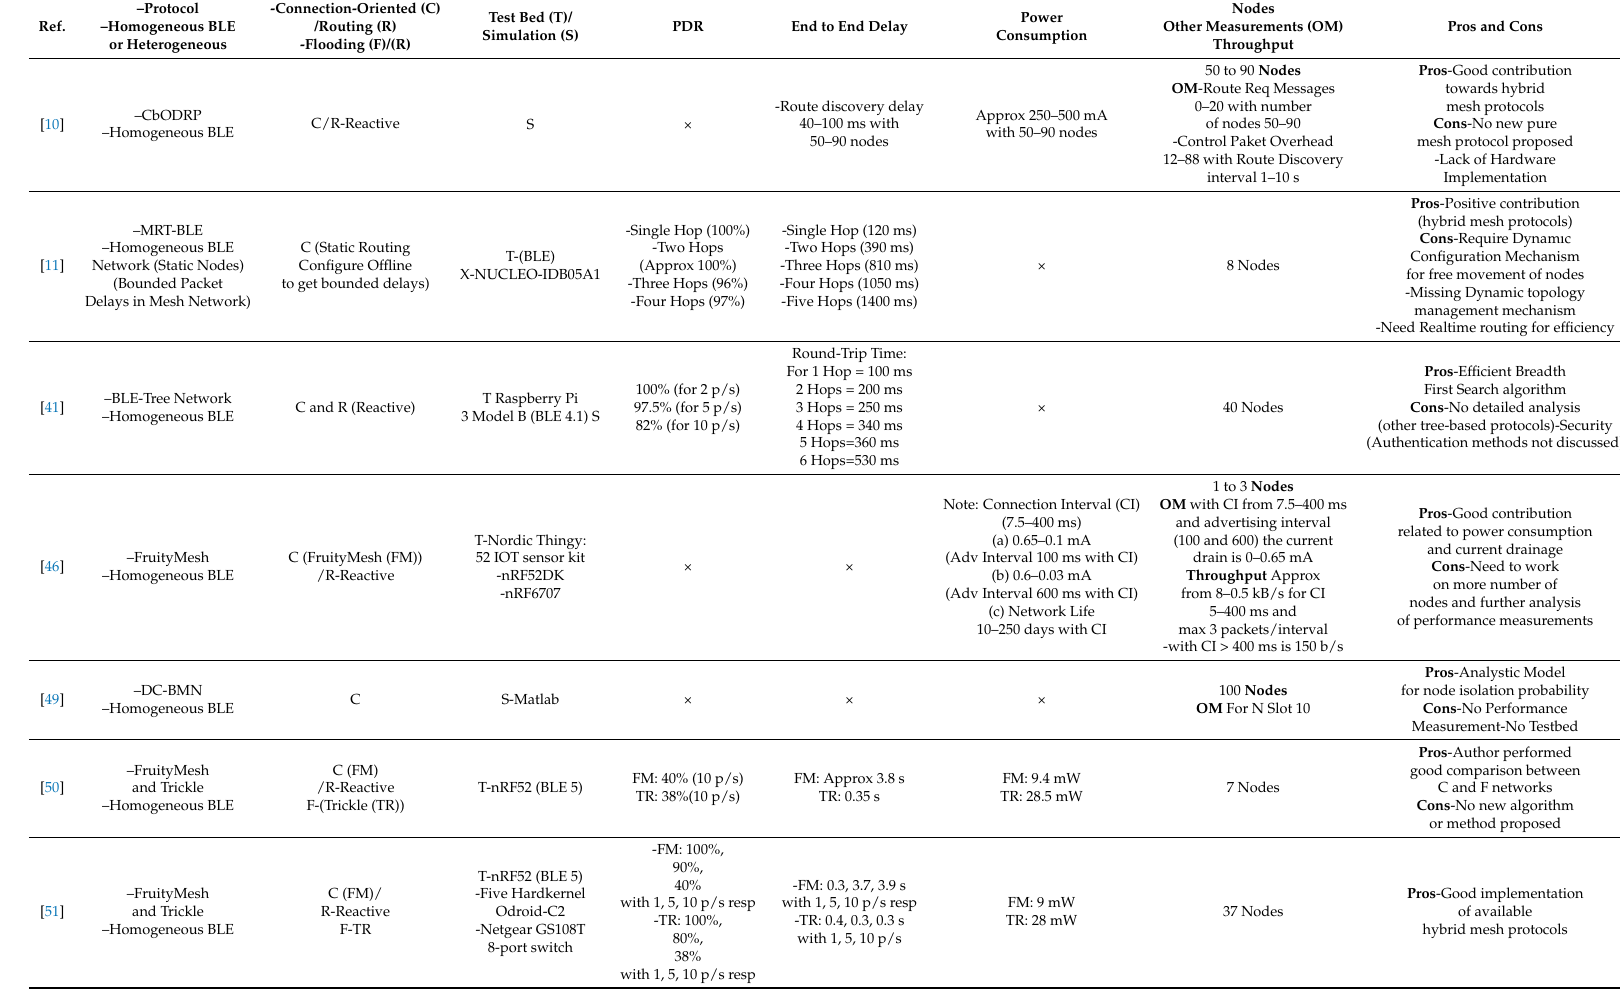
Table 1. Summary of various BLE Mesh